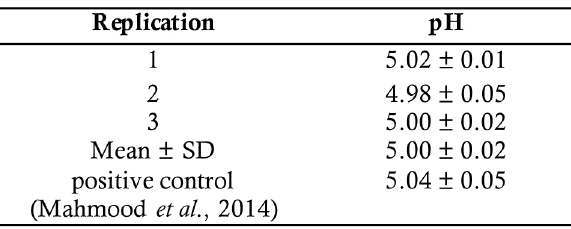
Table 3. pH of w/o/w multiple emulsion